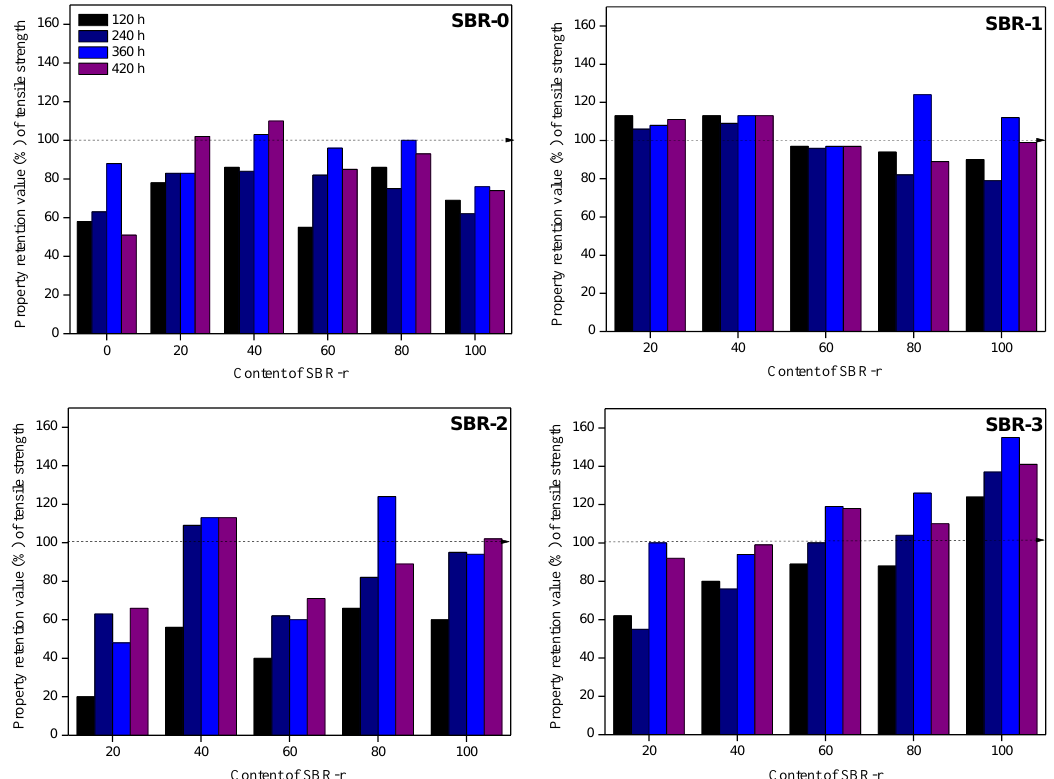
Figure 5. Property retention values (%) of tensile strength of the SBR-r composites after the aging in a UV chamber.